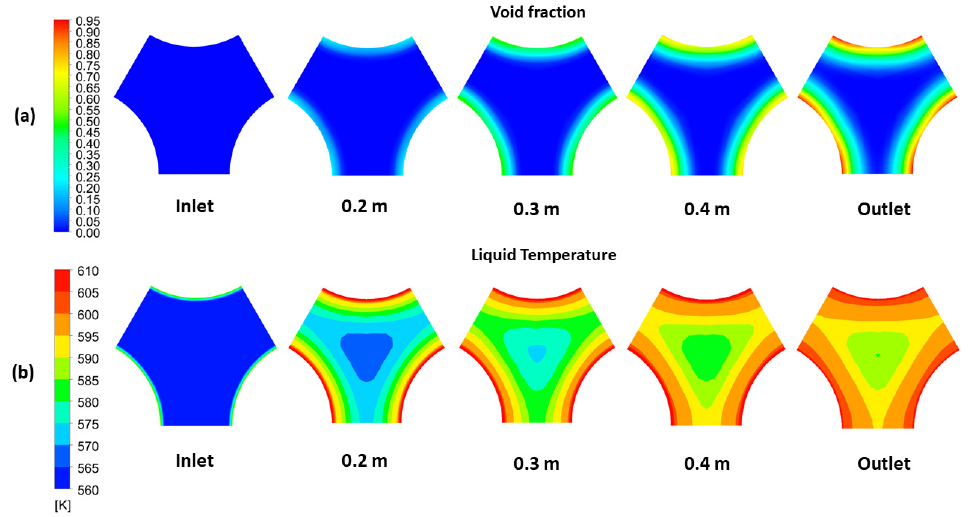
Figure 13. ( a ) Void fraction contours and ( b ) liquid temperature contours at various axial locations (inlet, 0.2 m, 0.3 m, 0.4 m, and outlet), respectively.